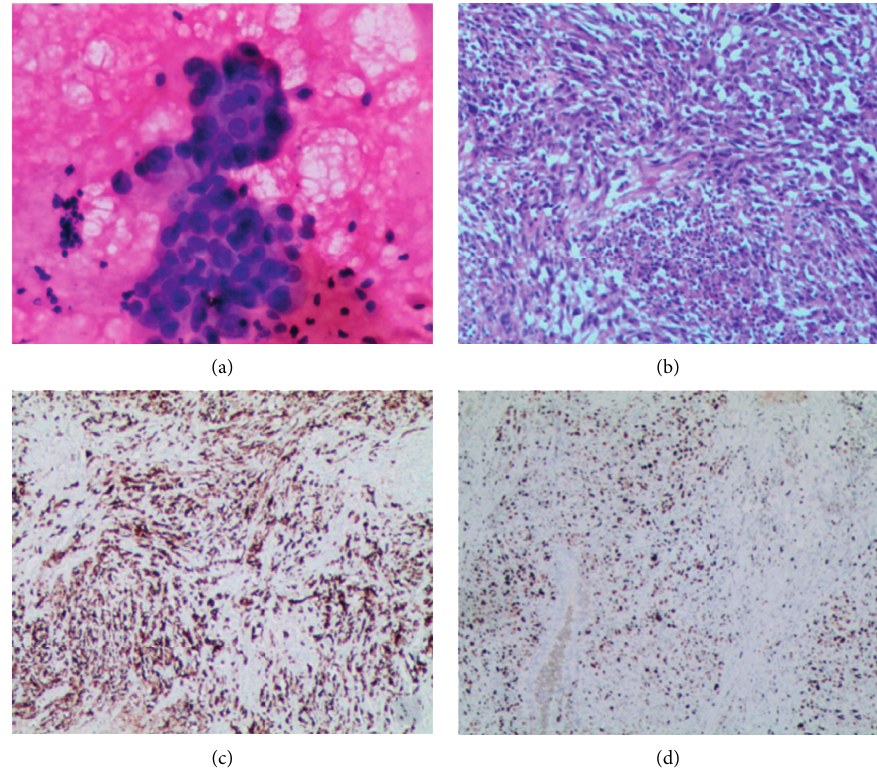
Figure 2: Pathological image of the patient diagnosed with lung adenocarcinoma in case 2 ((a) hematoxylin and eosin × 400). Pathological image of the patient diagnosed with PSC in case 2 ((b) pleomorphic carcinoma; hematoxylin and eosin × 100). Immunohistochemical images of the patient diagnosed with PSC in case 2 ((c) vimentin (+); (d) CK (+) taken using the Roche Ventana BenchMark XTautostainer ( × 100) (Roche Holding, Basel,